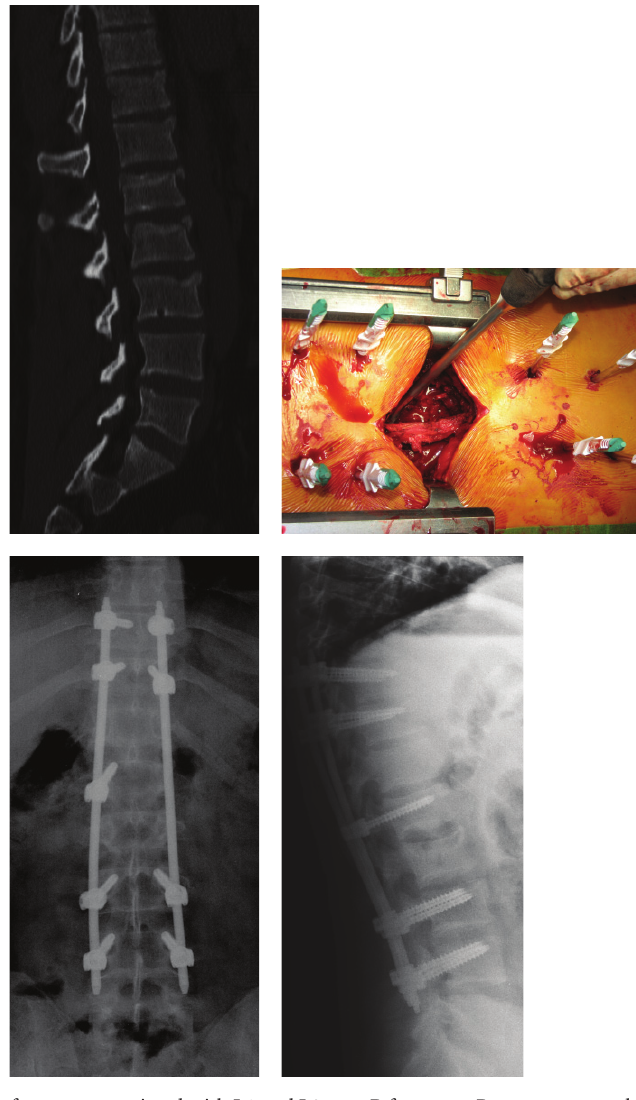
Figure 2: T11, T12, and L3 type A fractures associated with L1 and L2 type B fractures. Percutaneous stabilization from T10 to L4 and L1-L2 arthrodesis with a miniopen